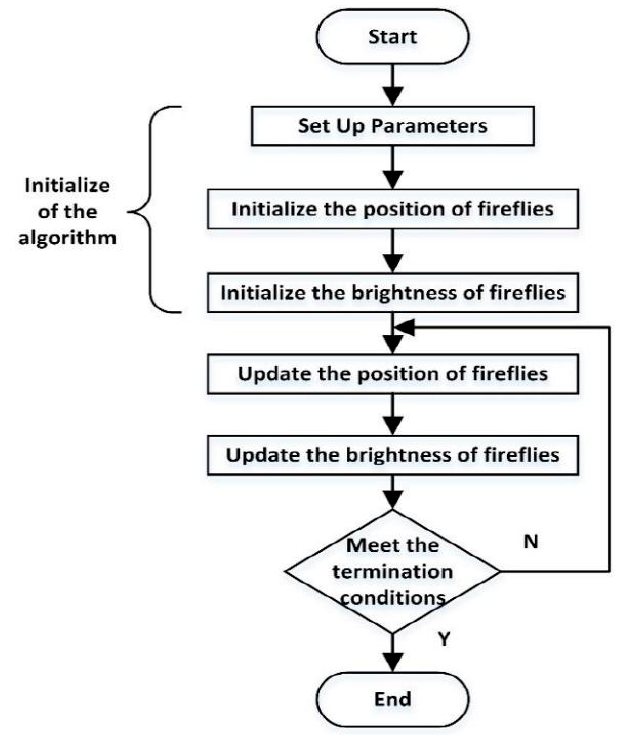
Figure 7. The flow of the firefly algorithm.